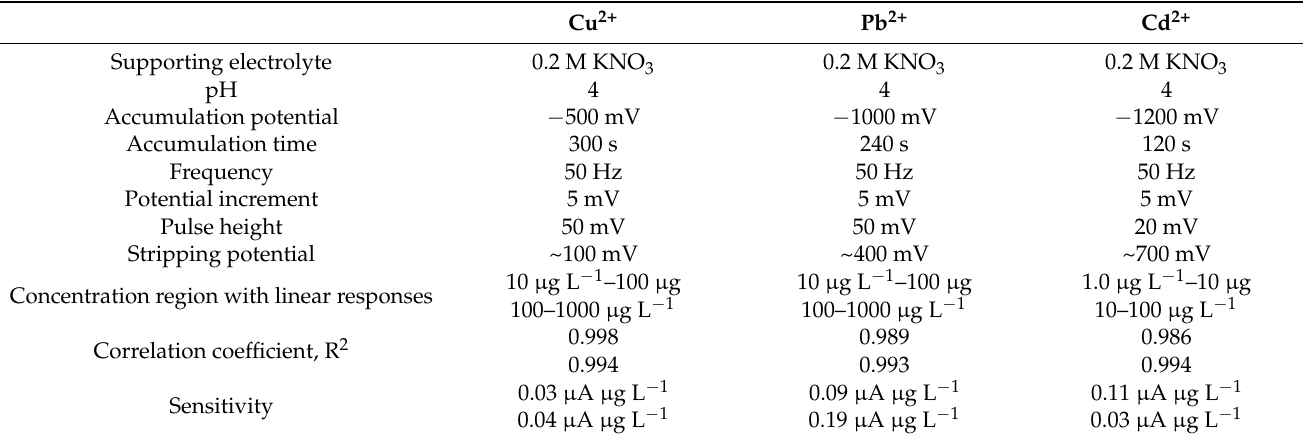
Table 2. Optimization parameters for the individual determination of copper, lead, and